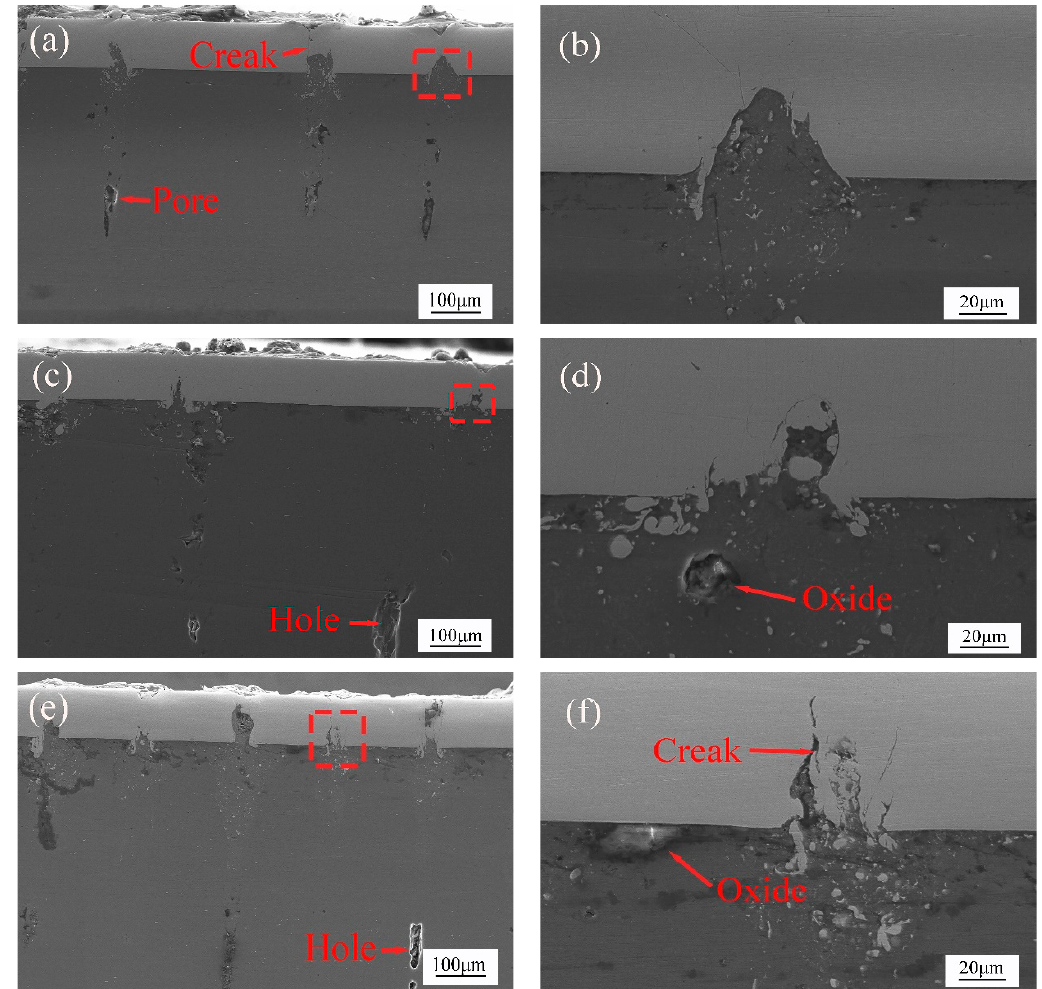
Figure 7. Cross sections of the welding seams under scanning electron microscopy ( a , b ) laser